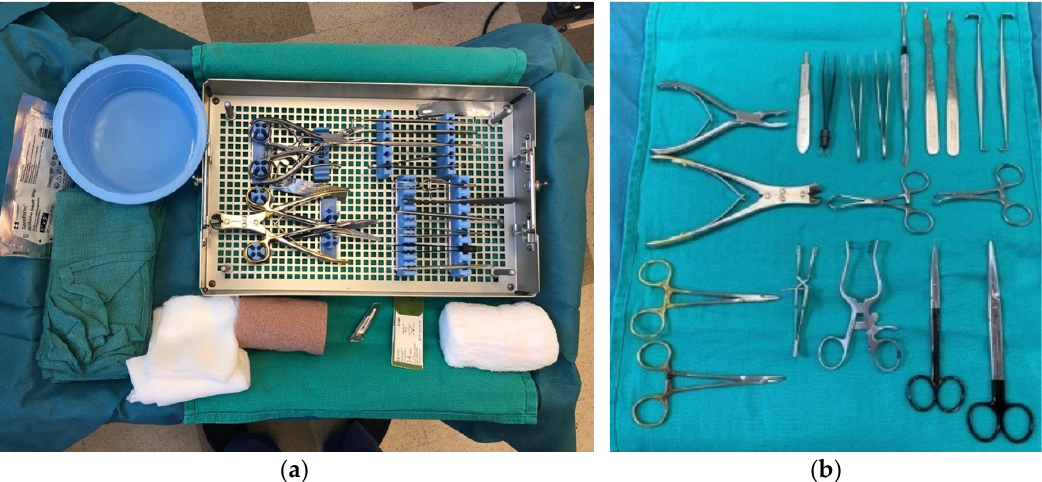
Figure 2. ( a ) Close-up of the surgical table in a clinic-based procedure room, holding a single-use tray of sterile instruments, sutures, wound dressing, gauze, Coban wrap, and a water basin. ( b ) Close-up of sterile instruments included in the single-use instrument tray.